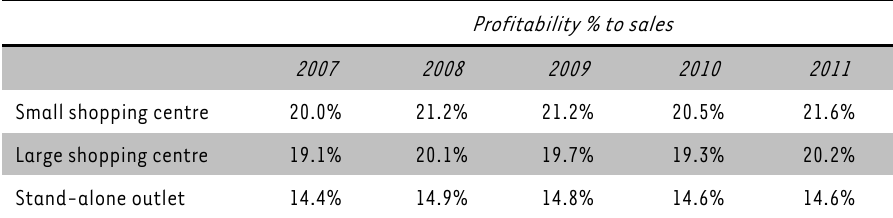
TABLE 12: Profitability percentage to sales by retail format